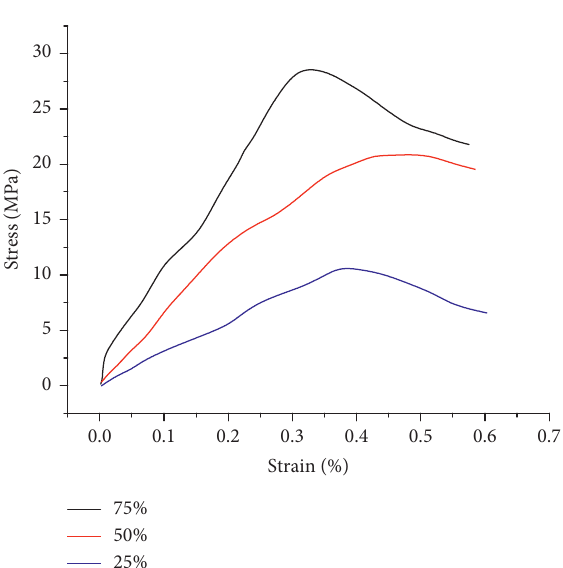
Figure 9: Numerical simulation of axial stress-strain curve with different thickness ratios.